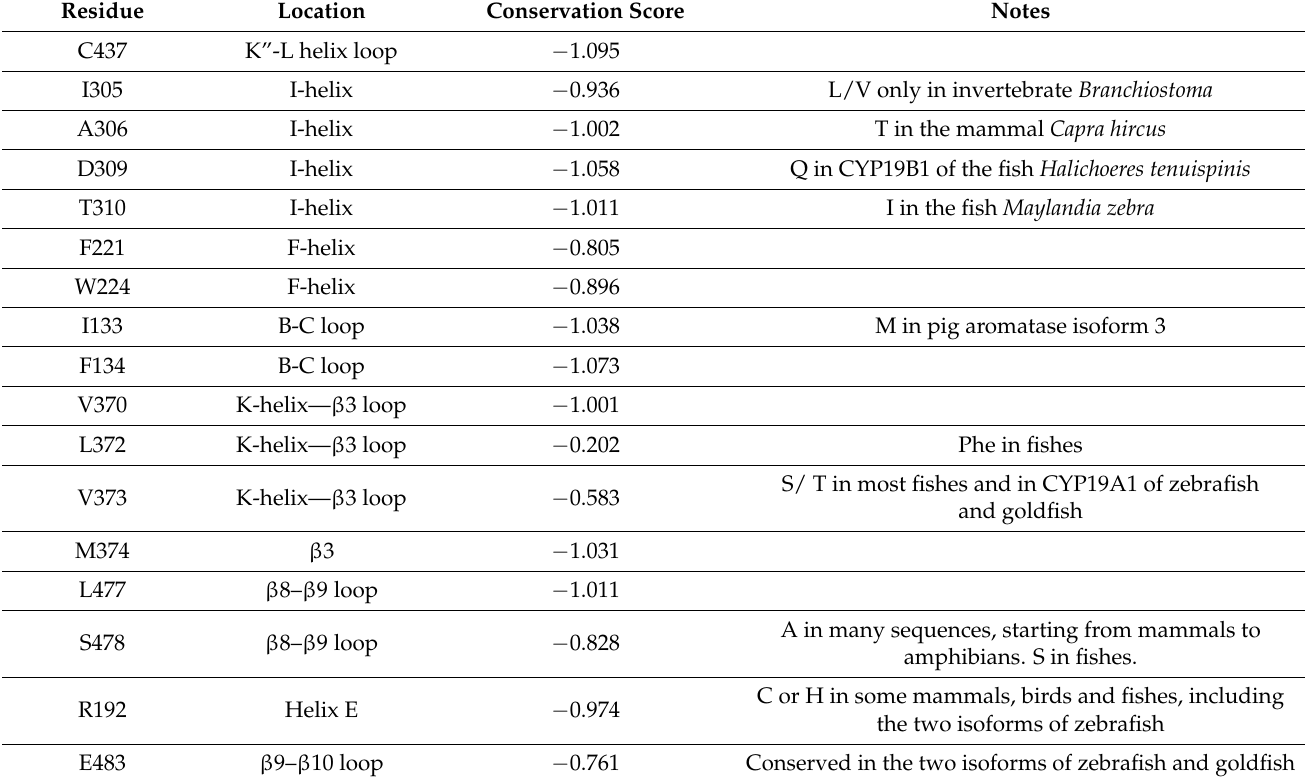
Table 1. Conservation of the residues involved in substrate binding and catalysis in human aromatase. The scores are normalized so that the average score for all residues is zero and the standard deviation is one. The lowest score represents the most conserved position in a protein. For reference, the lowest score associated with a fully conserved residue was − 1.103, whereas the highest score obtained for a nonconserved residue in human aromatase was +2.844. Residue Location Conservation Score